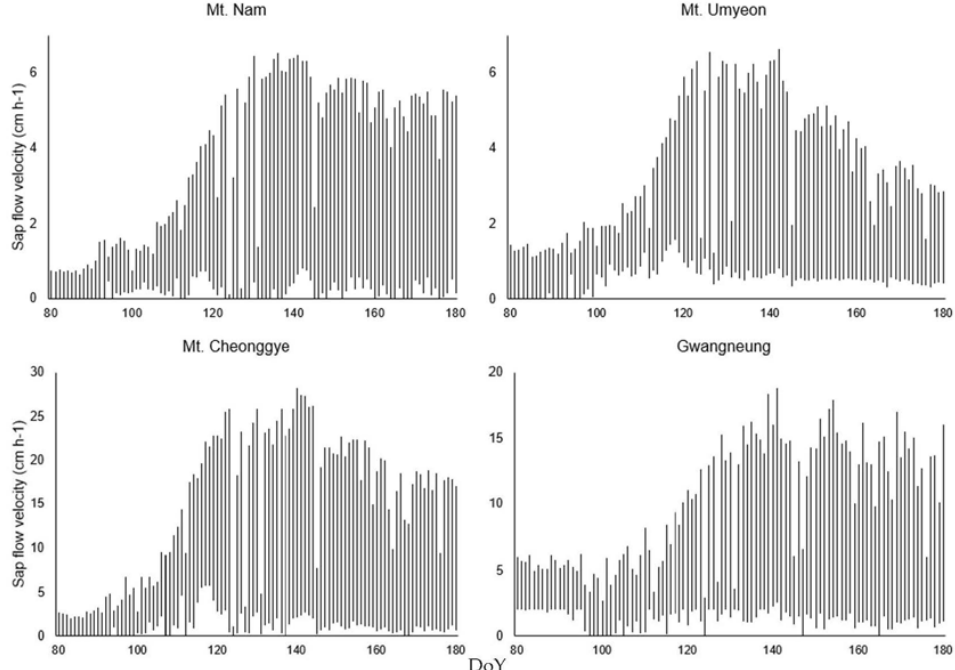
Figure 7. Changes in sap flow velocity during the study period in each site. Table 6. Comparisons of green-up dates derived from vegetation phenology (ExG and EVI) and sap flow (SFM).